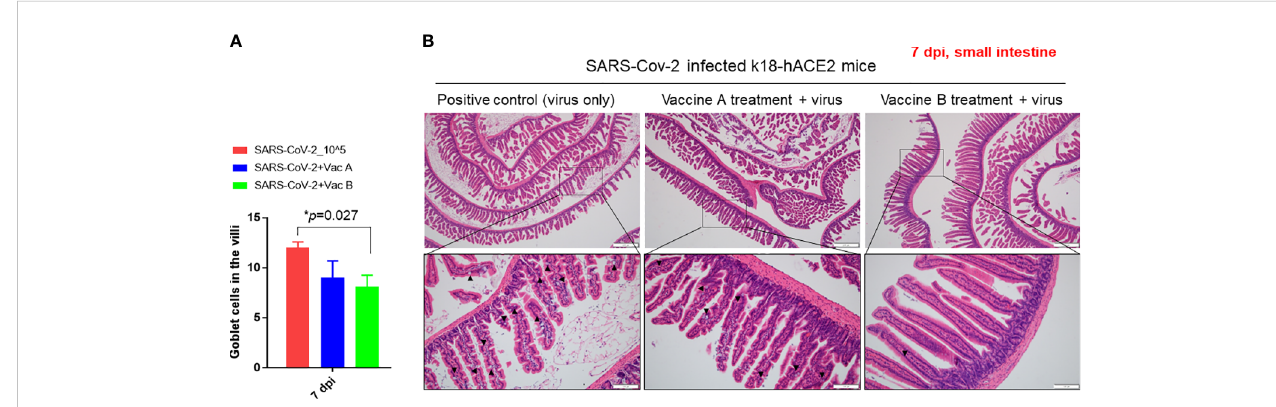
FIGURE 6 Pathological changes of K18-hACE2 TG mouse small intestines after SARS-CoV-2 infection, with and without vaccines. (A) Bar graph showing the number of goblet cells in villi in the three groups of mice. (B) Histopathology of mouse small intestine after being paraf fi n-embedded and stained with hematoxylin – eosin (H&E). Goblet cells are indicated in black arrows. Scale bars 50 µm (upper line) and 100 µm (lower line). *p < 0.05.